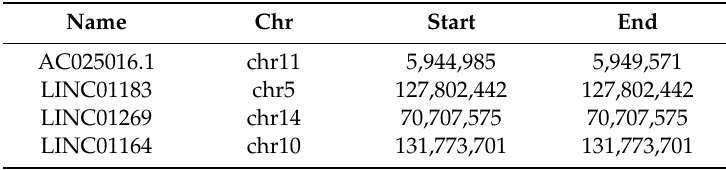
Table 1. 4-lncRNAs’ differential methylation region or site.